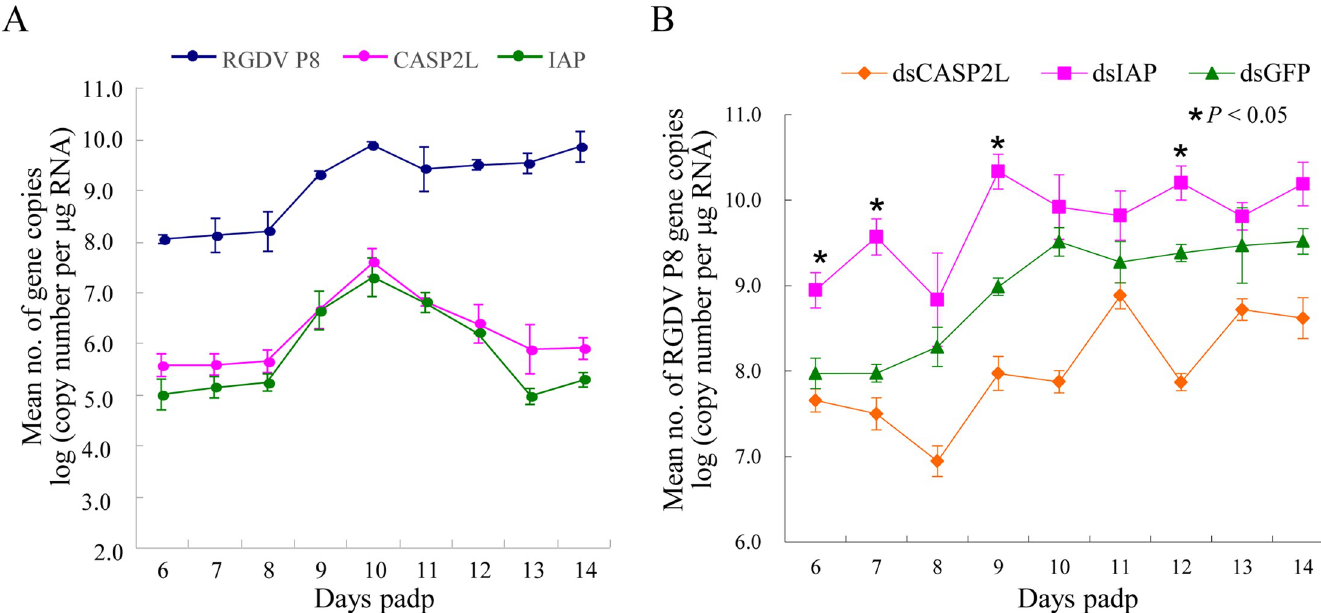
Fig 8. The apoptotic response regulated the persistent RGDV infection of R . dorsalis . (A) Mean number copies for RGDV P8, CASP2L or IAP genes in viruliferous leafhoppers from 6 to 14 days padp as determined by RT-qPCR assay. Means ( ± SD) from three independent biological replicates are shown. (B) Mean number of viral genome copies in dsCASP2L-treated, dsIAP-treated or dsGFP-treated viruliferous leafhopper from 6 to 14 days padp. Means ( ± SD) from three independent biological replicates are shown. Statistical significance is related to the dsGFP control. � P < 0.05.